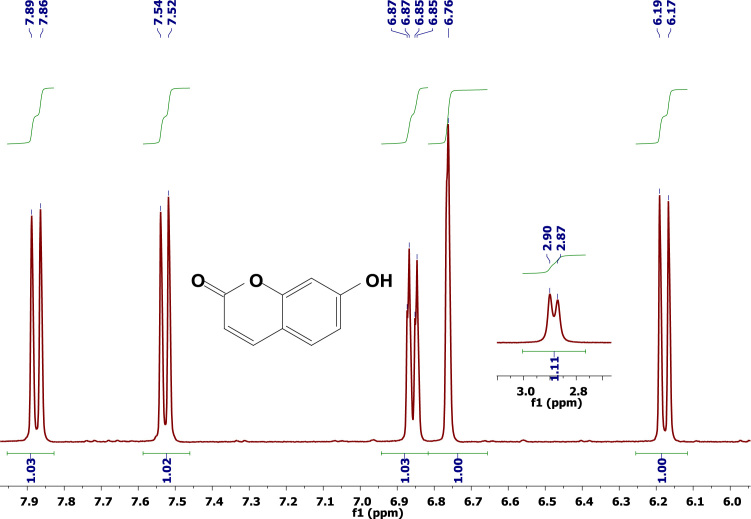
1H-NMR spectrum of umbelliferone (acetone-d6, 298 K, 400 MHz).